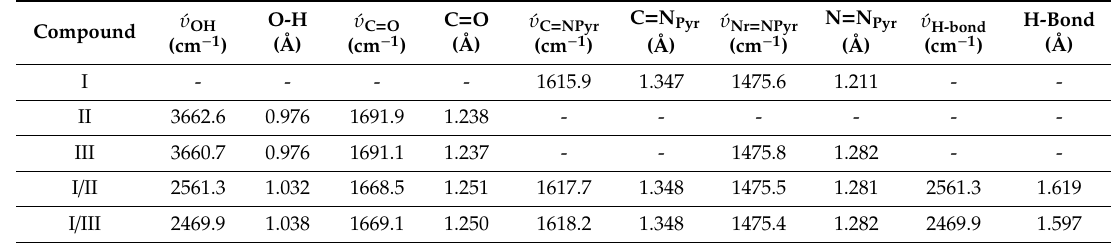
Table 1. The calculated bond length (Å) wave numbers (cm − 1 ) of characteristic groups of the base I , acids II and III and their supramolecular complex I / II and I / III .